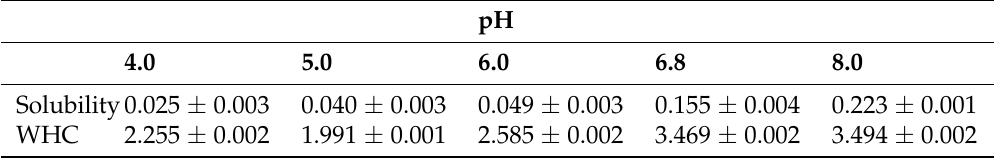
Table 2. Solubility and water holding capacity (WHC) in function pH for Vicia faba L. protein isolate.